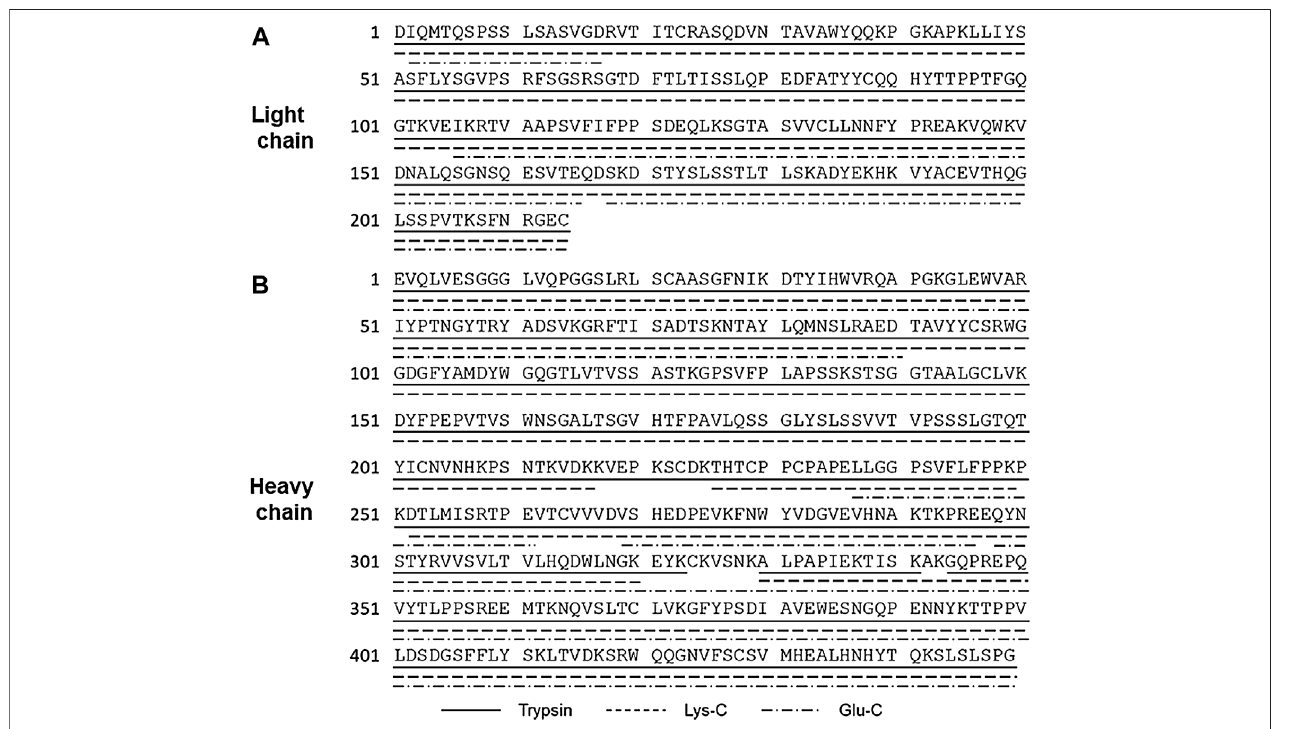
FIGURE 7 | Summary of peptide mapping of light chain (A) and heavy chain (B) using trypsin, Lys-C, and Glu-C. Peptide identi fi cation is summarized in Supplementary Table S5 .